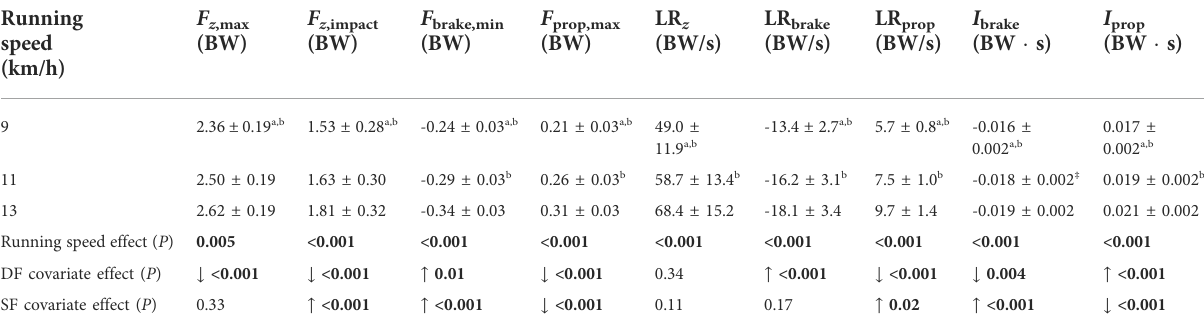
TABLE 3 Groundreaction force variablesfor runners at endurance running speeds. Signi fi cant differences ( P ≤ 0.05)identi fi ed by linear mixed effects modeling are indicated in bold. Running speed